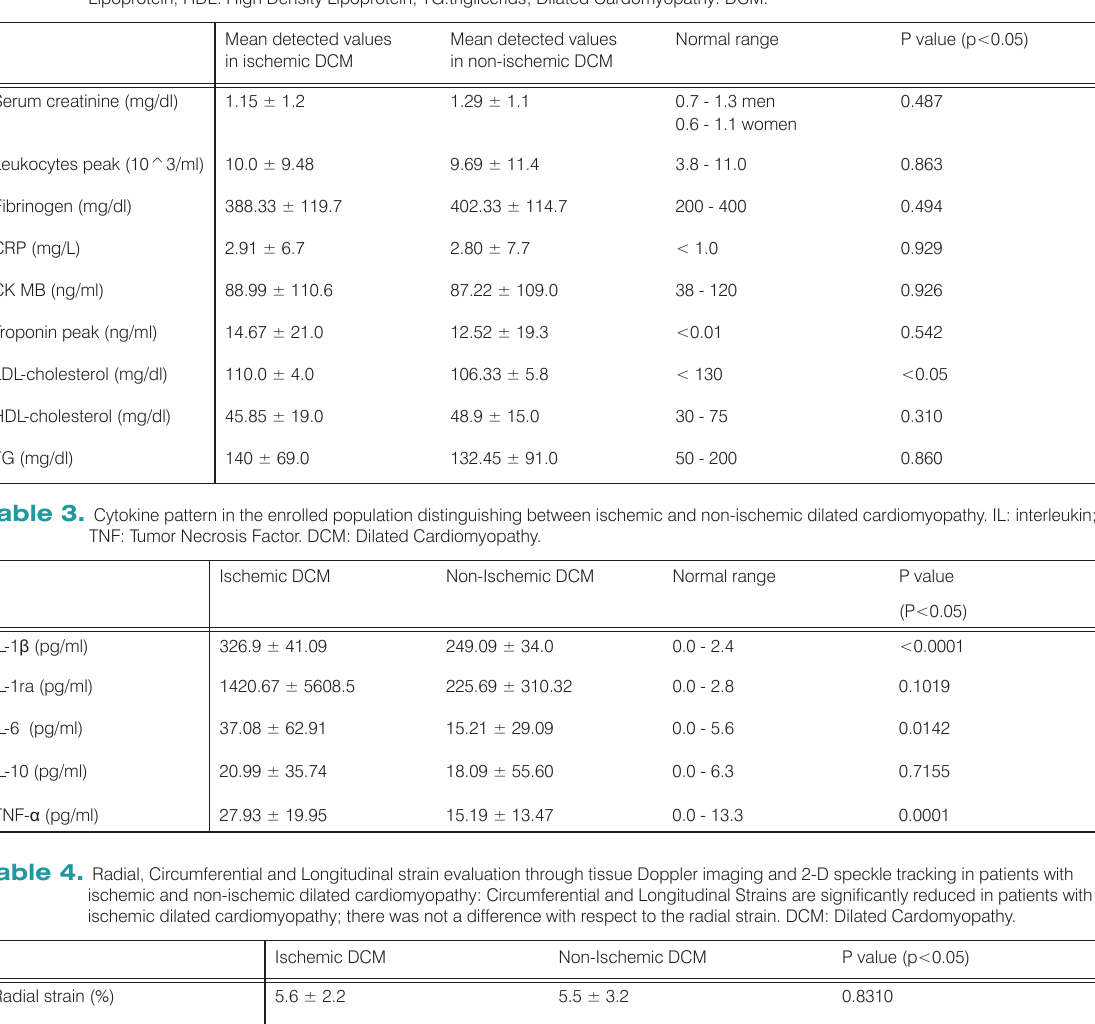
Table 2. Biochemical parameters evaluated in the studied population. CRP: C-Reactive Protein, CK MB: Creatine Kinase-MB; LDL:Low Density Lipoprotein; HDL: High Density Lipoprotein; TG:triglicerids; Dilated Cardomyopathy: DCM. Mean detected values Mean detected values Normal range P value (p<0.05) in ischemic DCM in non-ischemic DCM